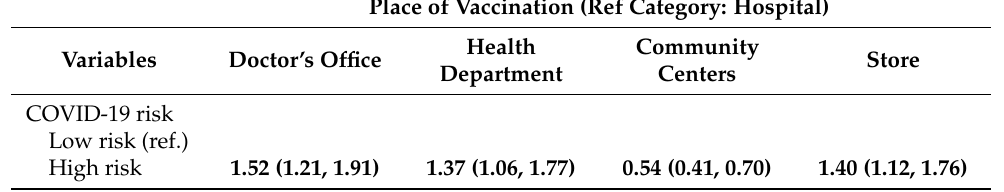
Table 3. Odds ratios and 95% CIs from multinomial logistic regression of place of vaccination on COVID-19 risk category, BRFSS